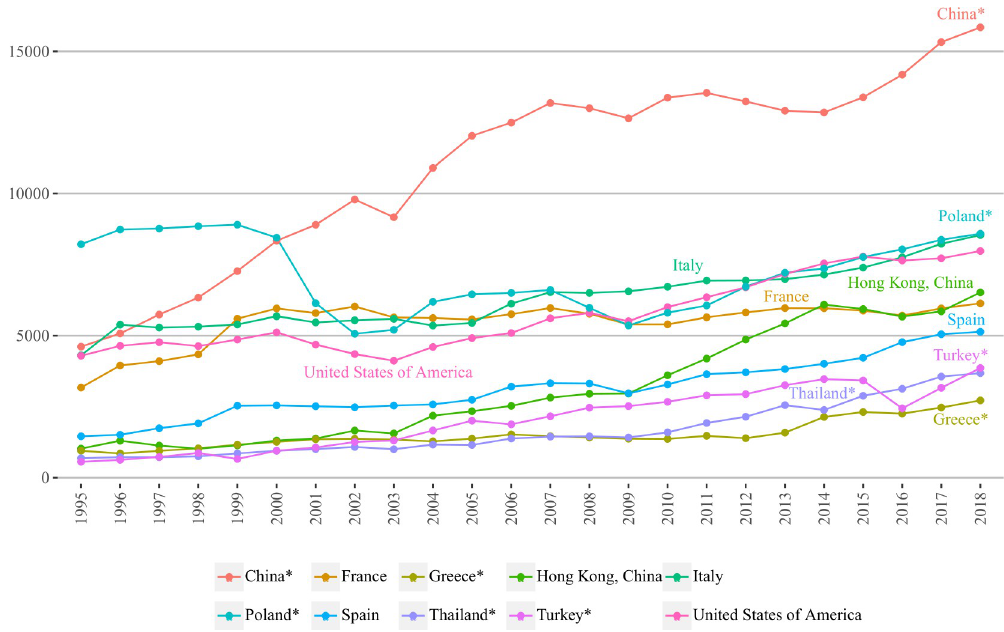
Fig 7. In-strength centralities of top five BRI and non-BRI countries/regions over 1995–2018. In 10 thousand people; countries/regions are selected based on the highest values of 2018 years; BRI marked with ‘ � ’.